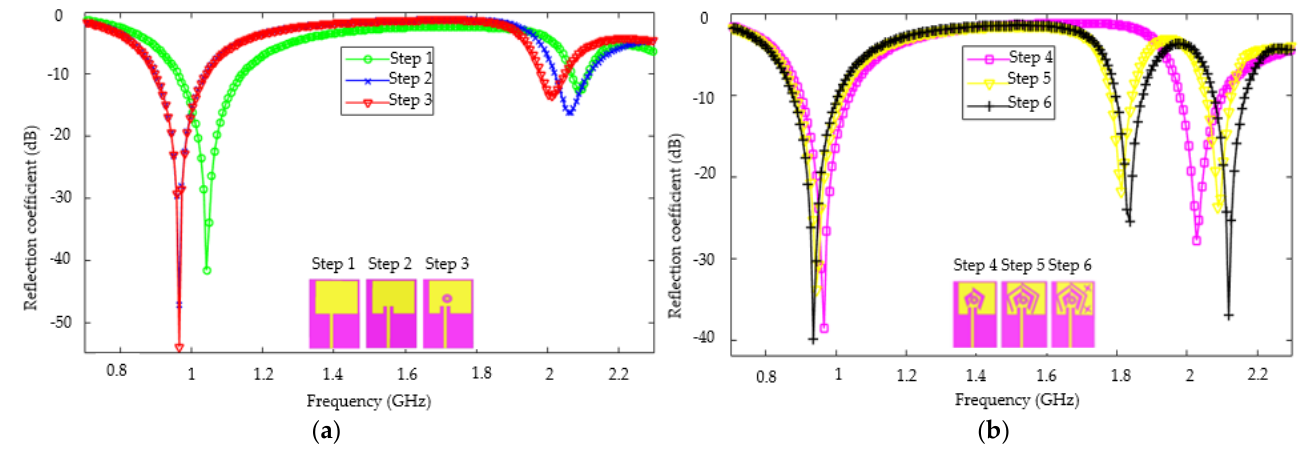
Figure 3. Reflection coefficient of the proposed antenna versus frequency: ( a ) from step 1 to step 3 and ( b ) from step 4 to step (6).